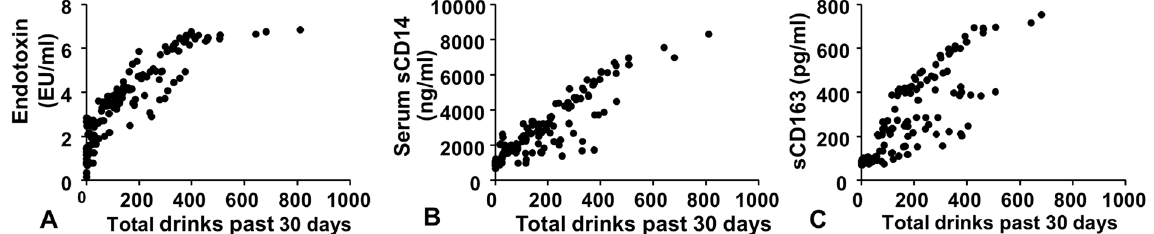
Figure 4. Relationship between serum LPS ( A ), sCD14 ( B ), and sCD163 ( C ) and quantity of alcohol consumption during the last 30 days as measured by timeline follow back. The serum levels of LPS, sCD14, and sCD163 were positively correlated with the quantity of alcohol consumption.